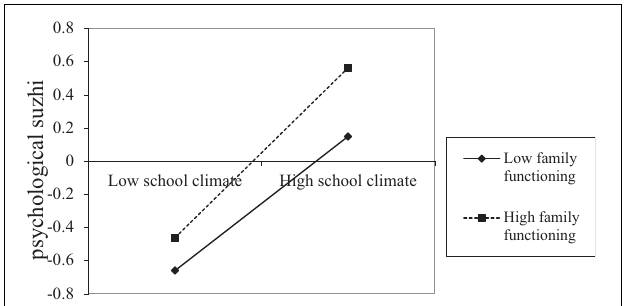
FIGURE 2 | Moderating effect of family functioning on the prediction of psychological